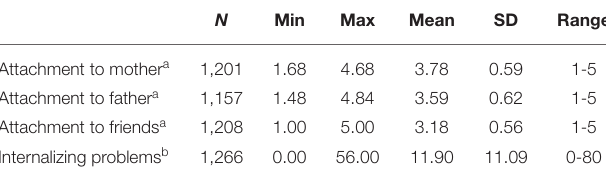
TABLE 1 | Descriptive statistics for the study variables ( N =